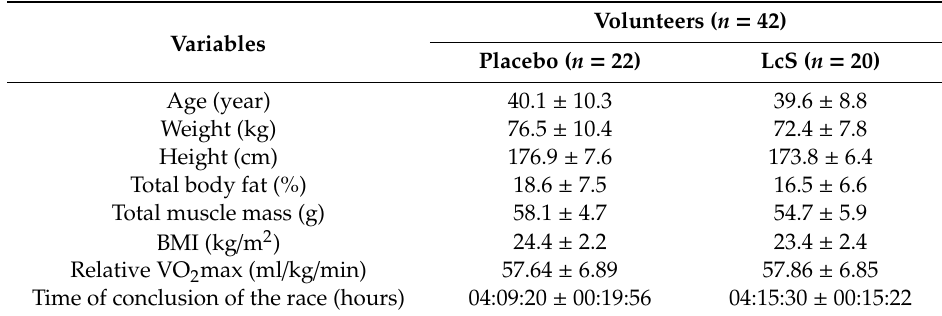
Table 1. Physical characteristics (age, weight, height, total body fat, total muscle mass and body mass index (BMI)), and aerobic capacity (relative VO 2 max) of the volunteers allocated in the groups LcS and placebo. All data were analyzed using Student’s t-test and are presented in mean and standard deviation. The level of significance was 5% ( p <